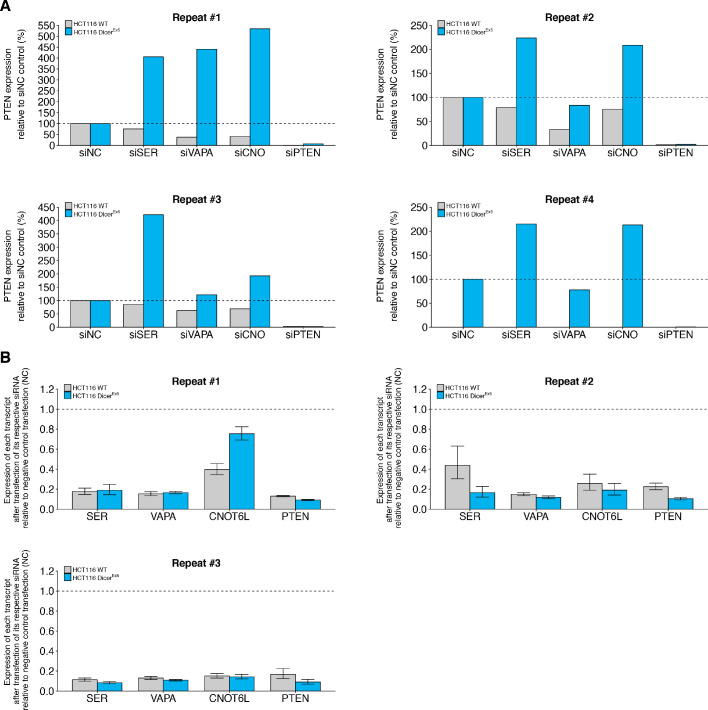
Knockdown efficiency and individual repeats of PTEN protein expression in wild-type and DICER mutant HCT116 cells transfected with siRNA against PTEN ceRNAs.This is the same experiment as Figure 1. (A) Independent biological repeats of Western blot assay. PTEN/HSP90 protein expression is presented for each condition relative to the siNC condition. (B) Independent biological repeats of RT-qPCR analysis. Expression of each transcript after transfection of its respective siRNA relative to negative control transfection (siNC) is presented. Transcripts listed on y-axis. Means reported and error bars represent SD from three technical replicates. One-sample t-tests of transcript expression data after transfection of respective siRNA to a constant of 1 (relative value of siNC). Wild-type HCT116 cells: SERINC1: t(2) = 8.41, uncorrected p=0.014, Bonferroni corrected p=0.055; VAPA: t(2) = 120, uncorrected p=6.98×10−5, Bonferroni corrected p=2.79×10−4; CNOT6L: t(2) = 10.4, uncorrected p=0.0091, Bonferroni corrected p=0.036; PTEN: t(2) = 30.6, uncorrected p=0.0011, Bonferroni corrected p=0.0043. DicerEx5 HCT116 cells: SERINC1: t(2) = 28.5, uncorrected p=0.0012, Bonferroni corrected p=0.0049; VAPA: t(2) = 48.3, uncorrected p=4.28×10−4, Bonferroni corrected p=0.0017; CNOT6L: t(2) = 3.23, uncorrected p=0.084, Bonferroni corrected p=0.336; PTEN: t(2) = 242, uncorrected p=1.71×10−5, Bonferroni corrected p=6.83×10−5. Additional details for this experiment can be found at https://osf.io/drcbw/.